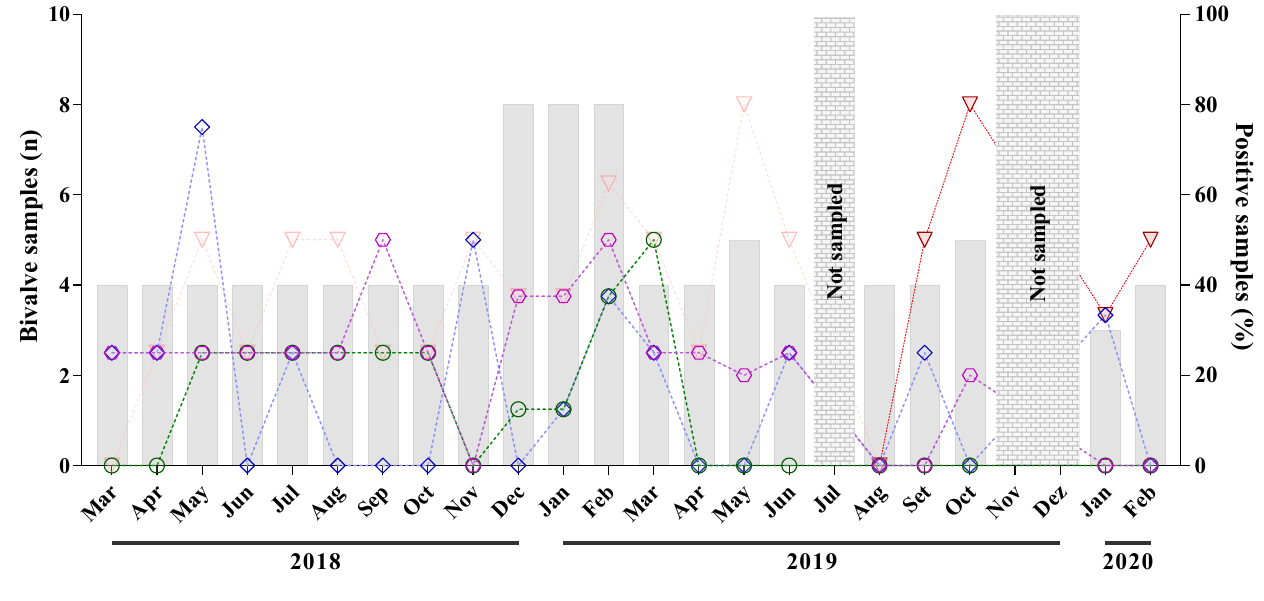
Figure 1. Distribution of bivalve shellfish samples collected from March 2018 to February 2020, with monthly positivity rates for norovirus (NoV), rotavirus A (RVA), human adenovirus (HAdV), and human bocavirus (HBoV) each month from March 2018 to February 2020. Initial norovirus results, published by Sarmento et al. [17], are shown in fading